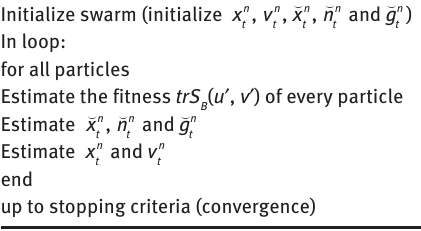
Table 1: Traditional PSO Algorithm. Initialize swarm (initialize